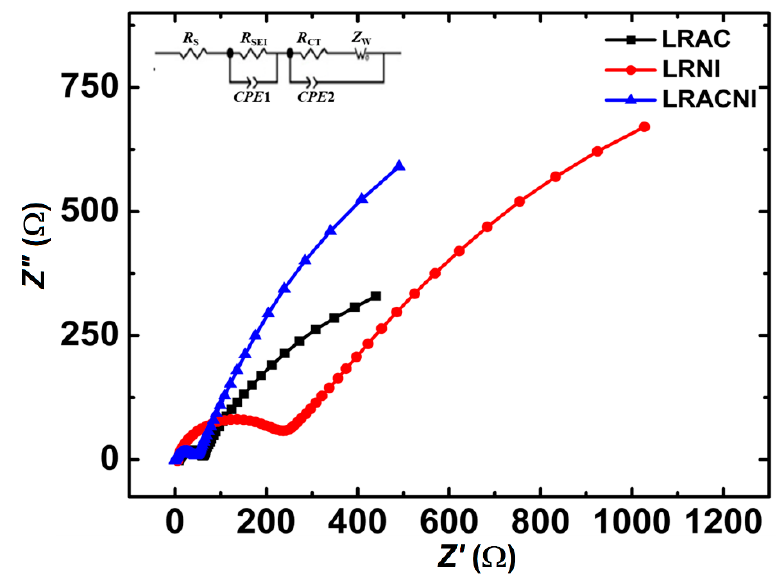
Figure 9. EIS spectra for LRAC, LRNI, and LRACNI electrodes, after the 10th cycle.